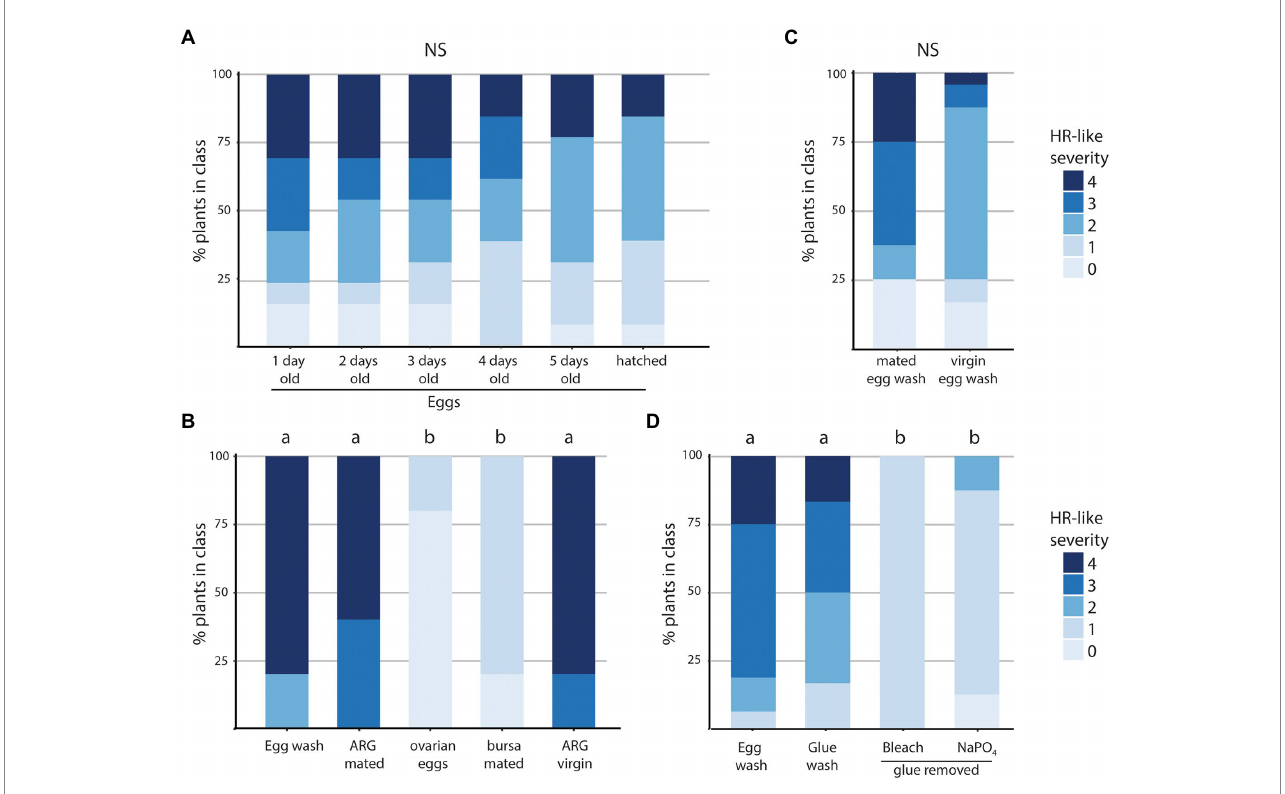
FIGURE 5 Proportion of HR-like cell death induced by washes made of eggs, washes made of tissues of the reproductive tract of Pieris brassicae, and washes of eggs with and without glue, in Brassica nigra . (A–D) (A) Egg washes made of eggs of different ages or eggshells and egg glue remaining on filter paper. N plants = 13–26 (B) Egg wash of dissected structures of reproductive tract. N plants = 5. (C) Egg wash of eggs of mated females versus virgin females. N plants = 8–24 (D) Wash of eggs, glue alone (in filter paper) or wash of eggs with egg-enveloping secretions removed. For glue removal, two treatments were